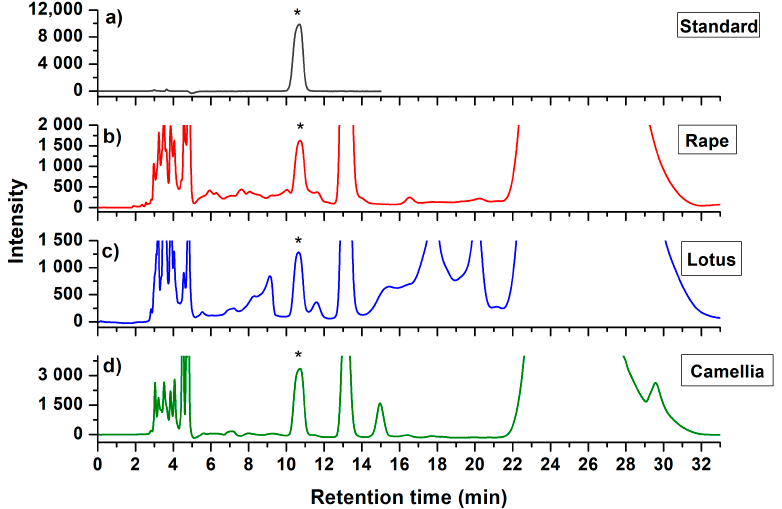
Figure 2. Representative chromatograms of ( a ) ascorbic acid standard, and the final extract of ( b ) rape ( Brassica campestris ), ( c ) lotus ( Nelumbo nucifera ), and ( d ) camellia ( Camellia japonica ) bee pollen. Asterisks indicate the peak of ascorbic